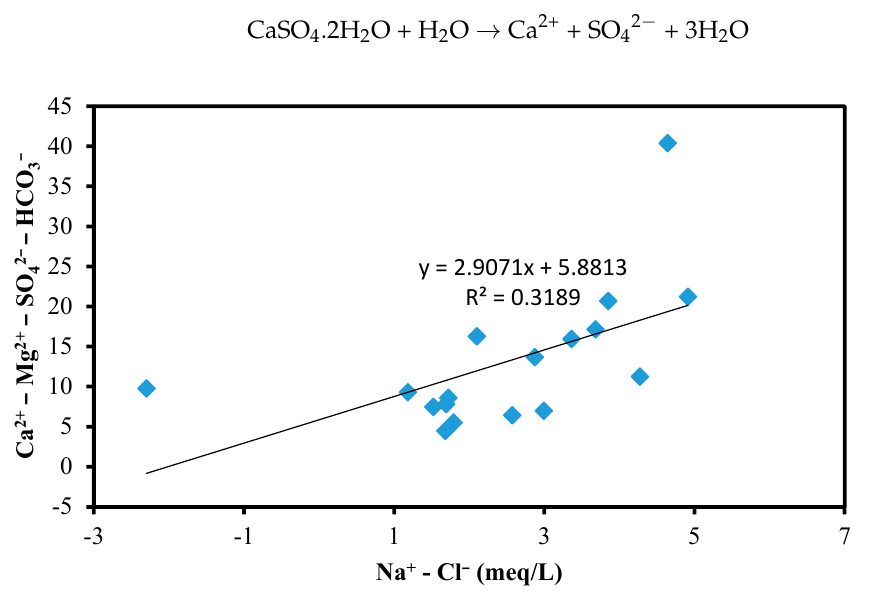
Figure 10. Ca 2+ + Mg 2+ − SO 42 − − HCO 3 − versus Na + − Cl − in the groundwater of the catchment. A plot of Ca 2+ + Mg 2+ versus SO 42 − + HCO 3 − (Figure 11) was used to determine the role